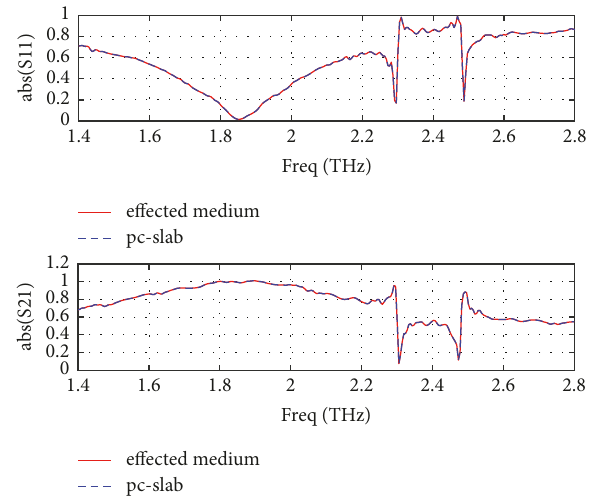
Figure 13: Scattering parameters comparison between the photonic crystal and effective